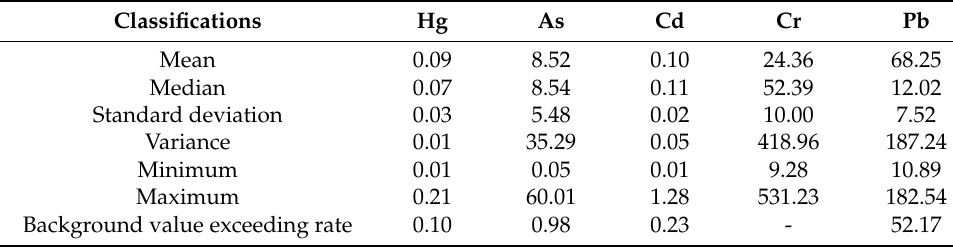
Table 9. Statistical table of detection values of heavy metals in deep soil.